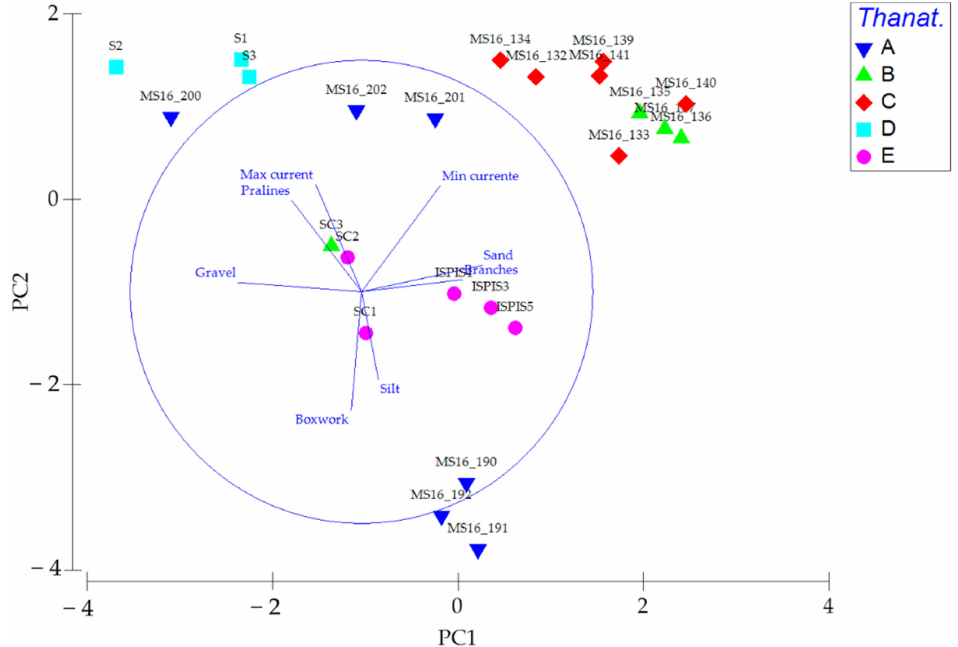
Figure 8. Graph of the principal component analysis that considers all the environmental data (current values, grain size, depth), together with morphotype coverage